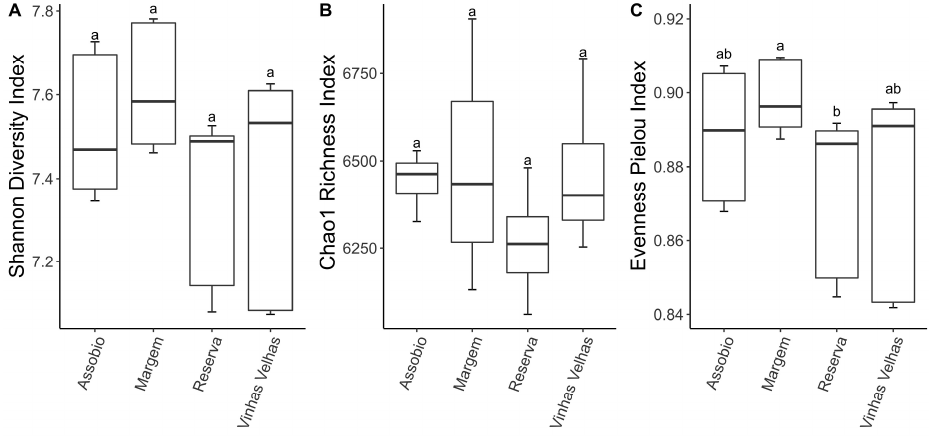
Figure 2. Shannon diversity index ( A ) Chao1 richness index ( B ) and Pielou evenness index ( C ). Boxplots depict N = 9 per terroir; centre line: median; lower and upper hinges: first and third quartiles (the 25th and 75th percentiles); whiskers: × 1.5 the interquartile range; letters denote significant differences at p < 0.05.